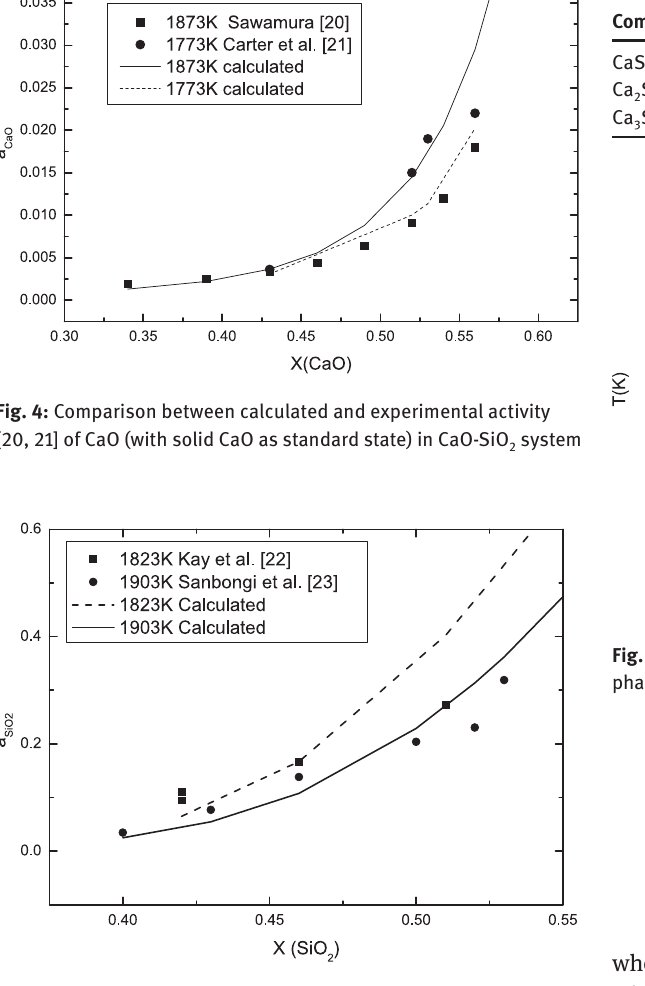
Fig. 5: Comparison between calculated and experimental activity [22, 23] of SiO 2 (with solid SiO 2 as standard state) in CaO-SiO 2